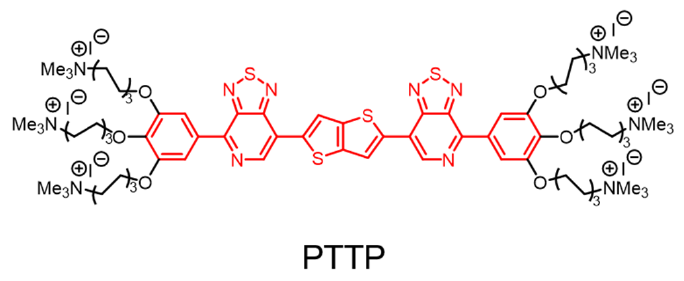
Figure 5. Structure of conjugated oligo-electrolyte PTTP.